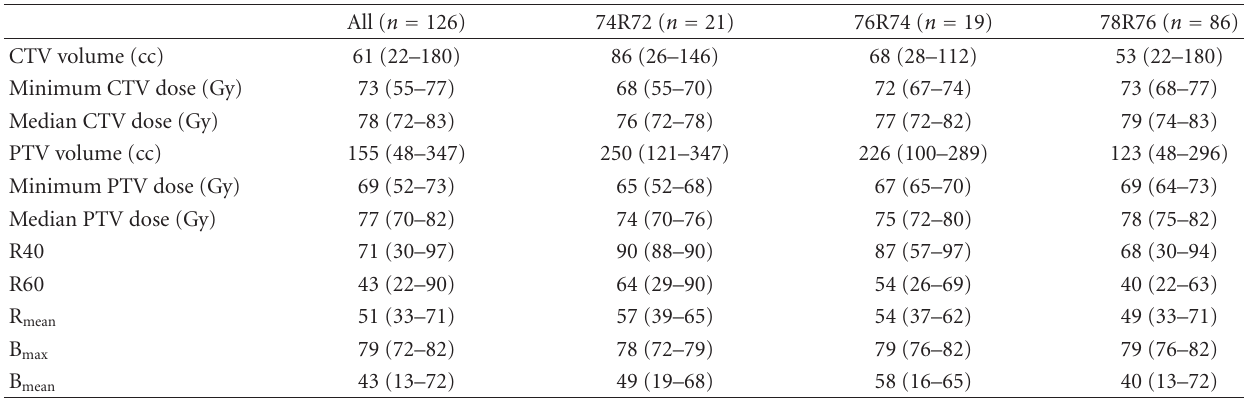
Table 3: Planning parameters for all patients and according to prescription. CTV: clinical target volume; Gy: Gray; PTV: planning target volume; R40 and R60: percentage of the rectal volume receiving a dose of 40 and 60 Gy, respectively; R mean : mean dose to the rectum, B max and B mean : maximal and mean dose to the bladder.